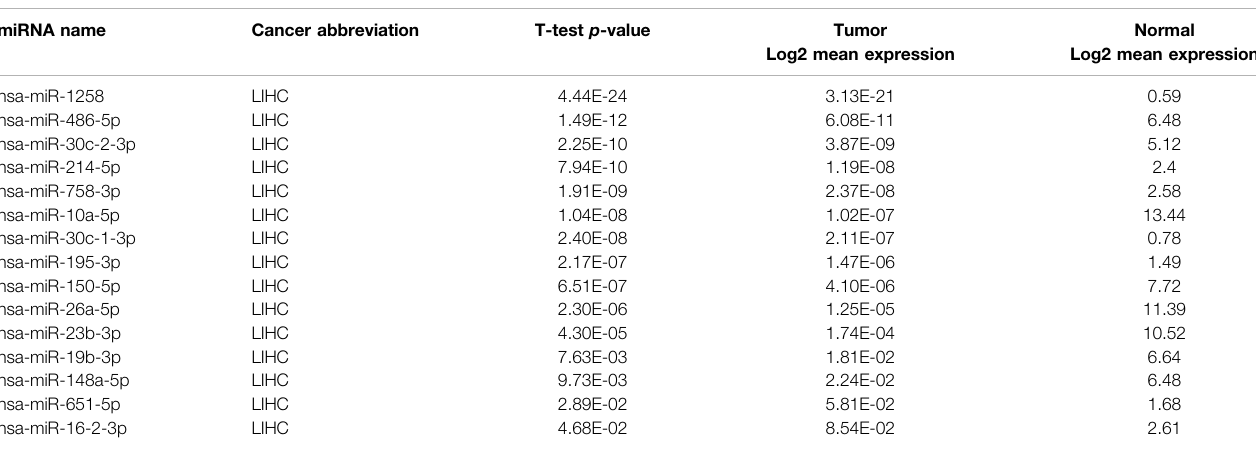
TABLE 2 | Differential expression analysis of the predicted miRNAs in